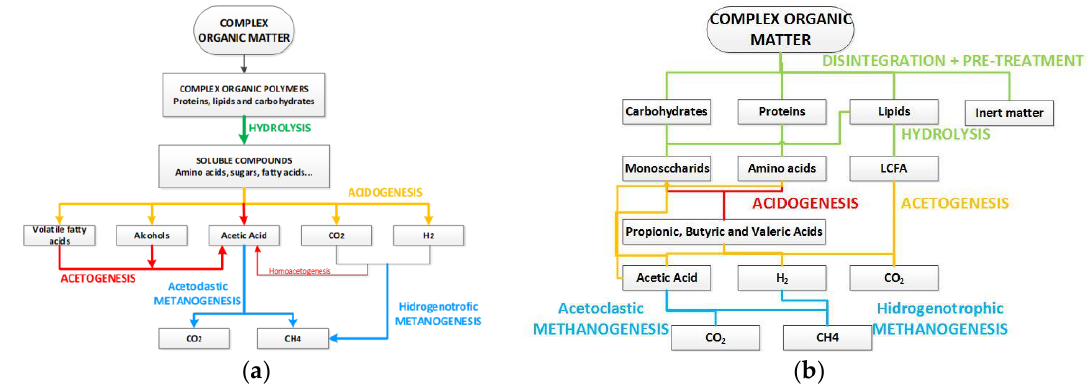
Figure 2. Anaerobic digestion process and reactions. ( a ) Simplified way and ( b ) adapted from [75] for ADM1 Simulation.